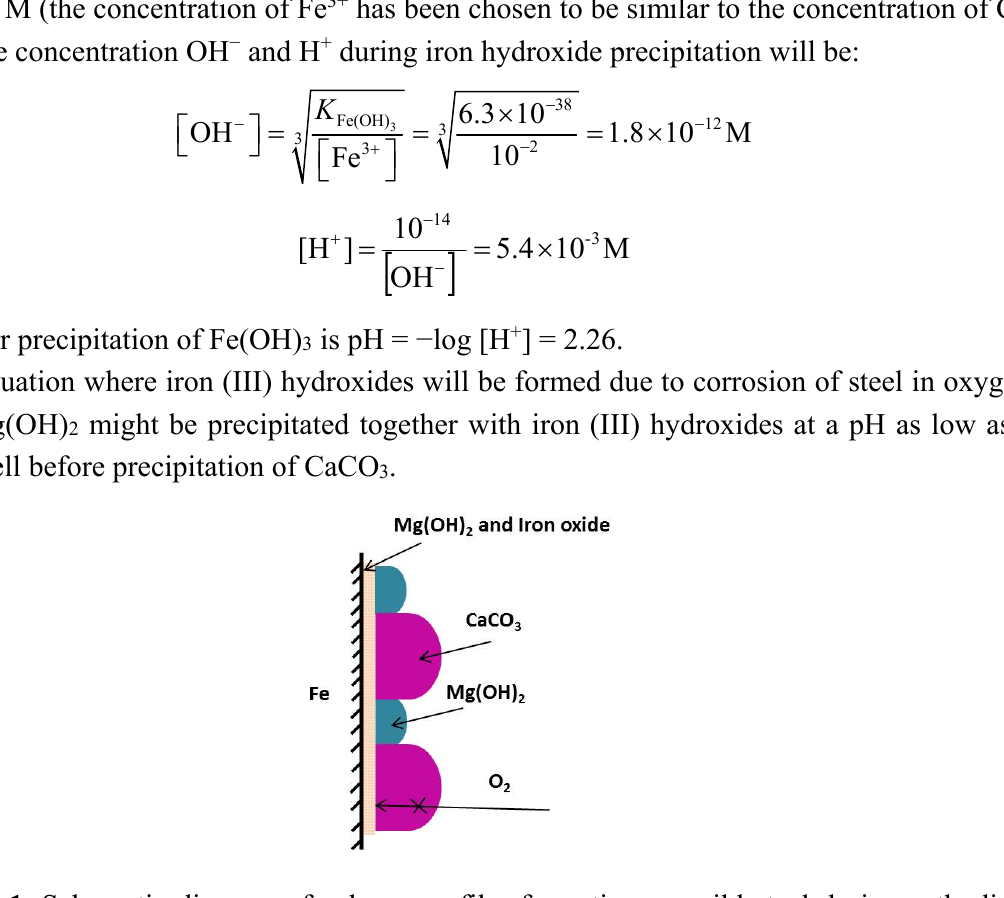
Figure 1. Schematic diagram of calcareous film formation on mild steel during cathodic protection in artificial seawater